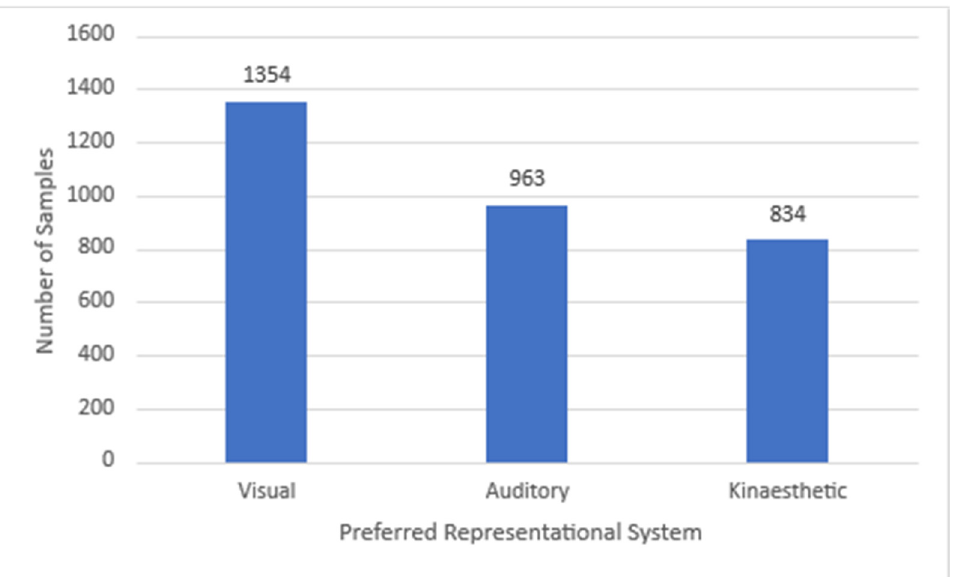
Figure 2. Number of Visual, Auditory and Kinaesthetic preferred representational systems identified by NLP practitioners.